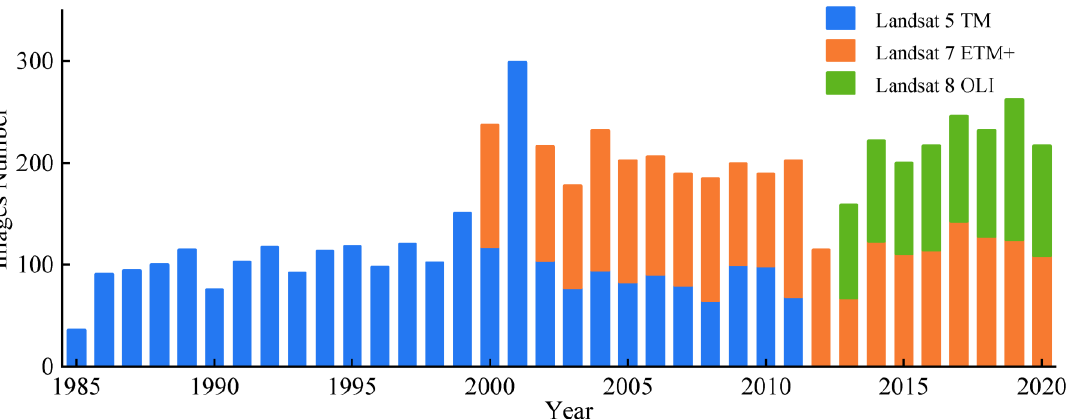
Figure 2. The number of available Landsat images for TM, ETM+, and OLI sensors per year in HQSL.